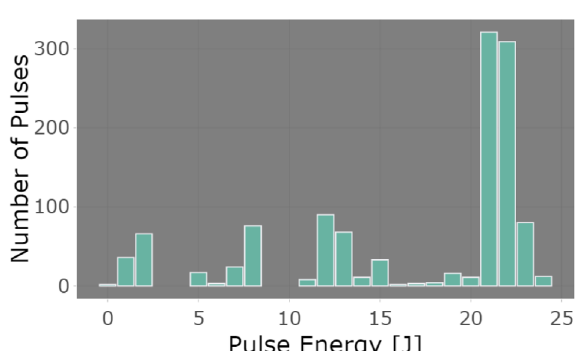
Figure 3. Energy distribution of the pulses delivered in the 1 PW experimental area (reproduction from [6]).